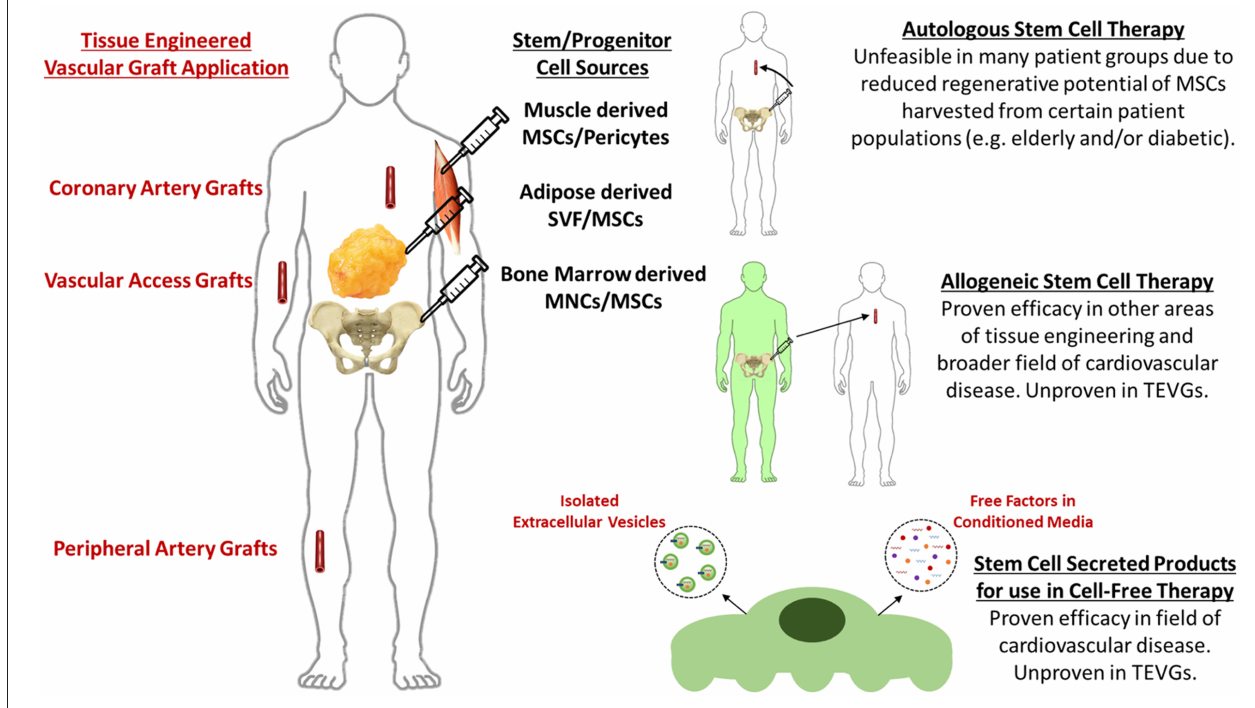
FIGURE 1 | Current methods and future perspectives for stem cell-based tissue engineered vascular